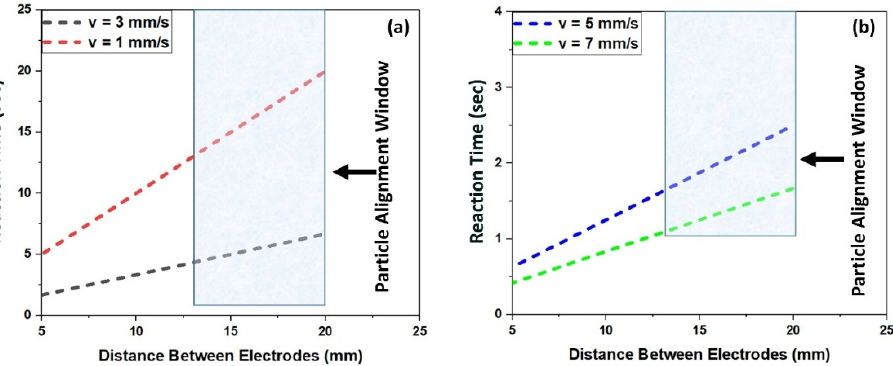
Figure 5. Correlation between reaction time and distance between the electrodes for printing speeds of: ( a ) 1 and 3 mm/s, and ( b ) 7 and 5 mm/s.